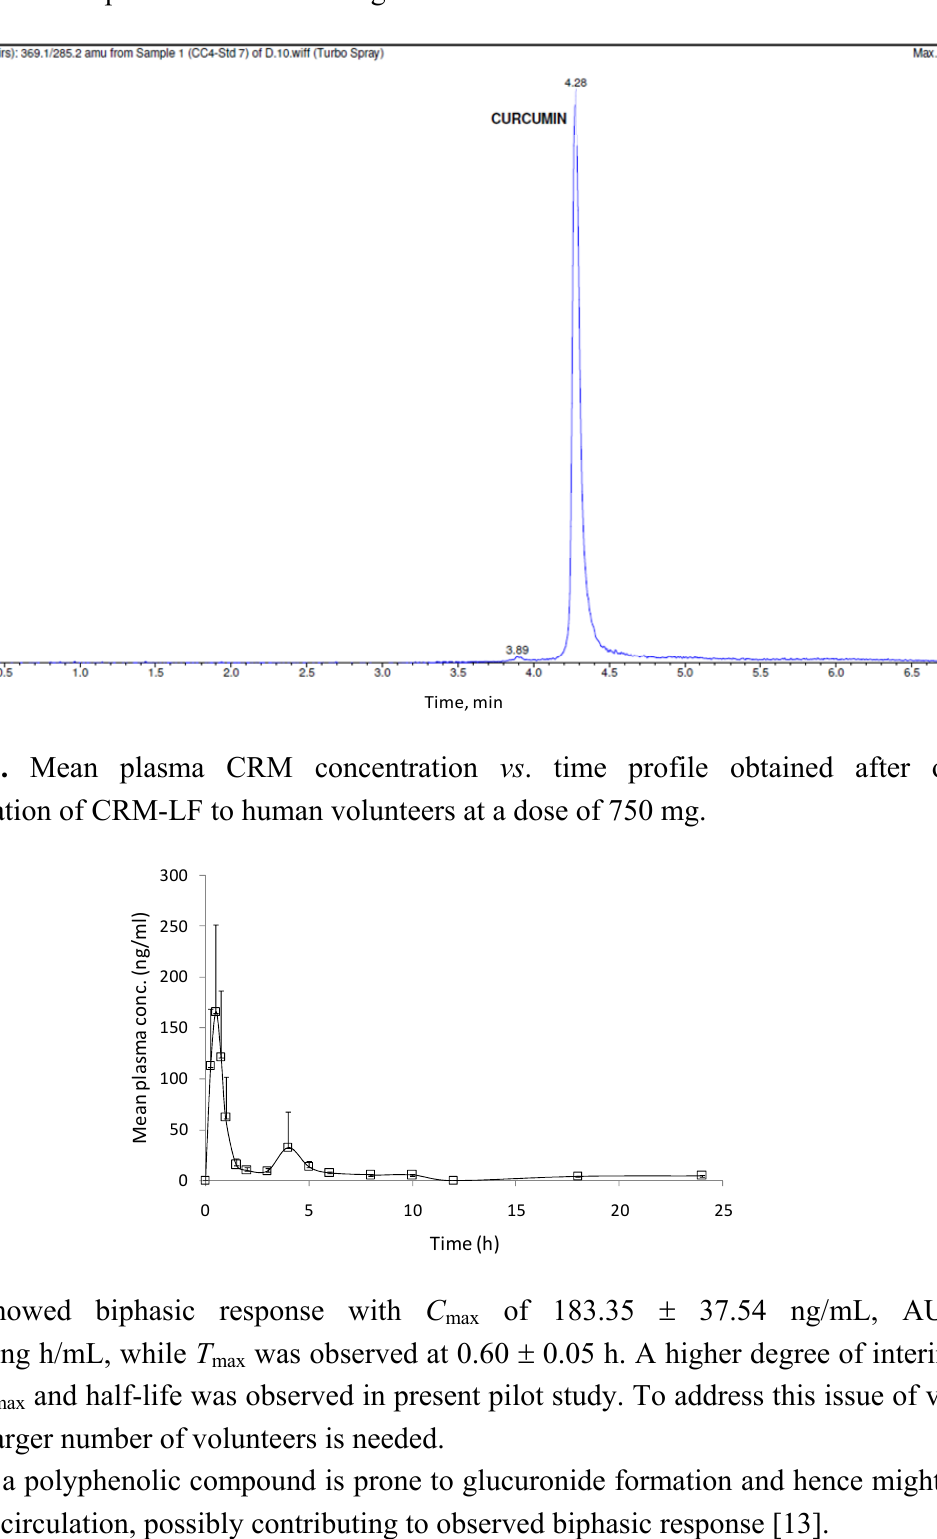
Figure 2. Representative chromatogram for calibration curve standard of CRM.